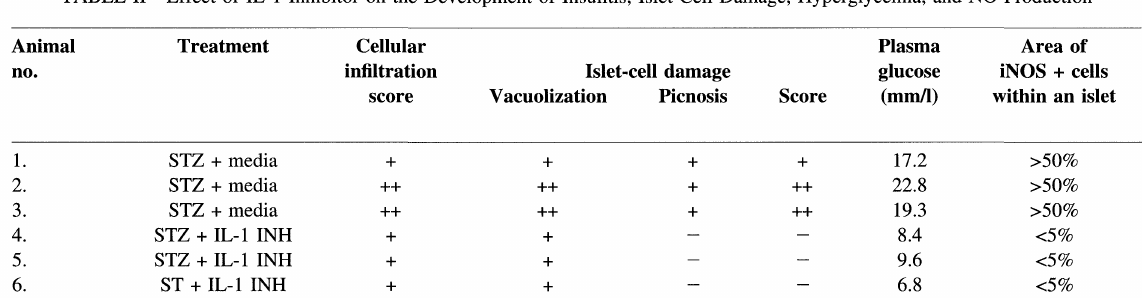
TABLE II Effect of IL-1 Inhibitor on the Development of Insulitis, Islet-Cell Damage, Hyperglycemia, and NO Production Animal Treatment